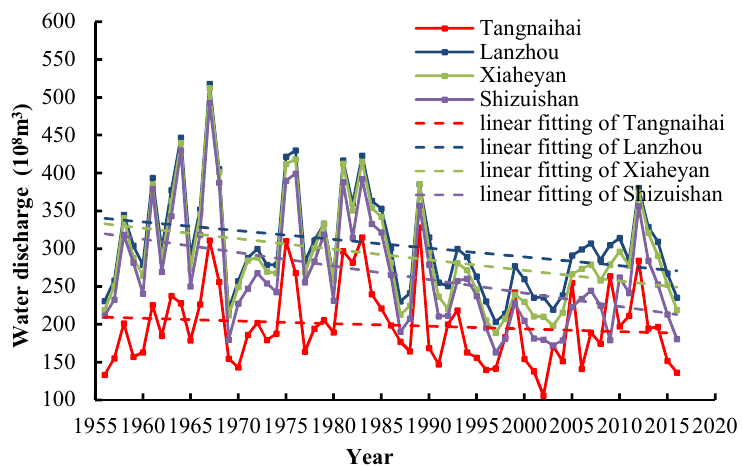
Figure 2. Variation trend of annual streamflow of the upper reaches in the Yellow River.